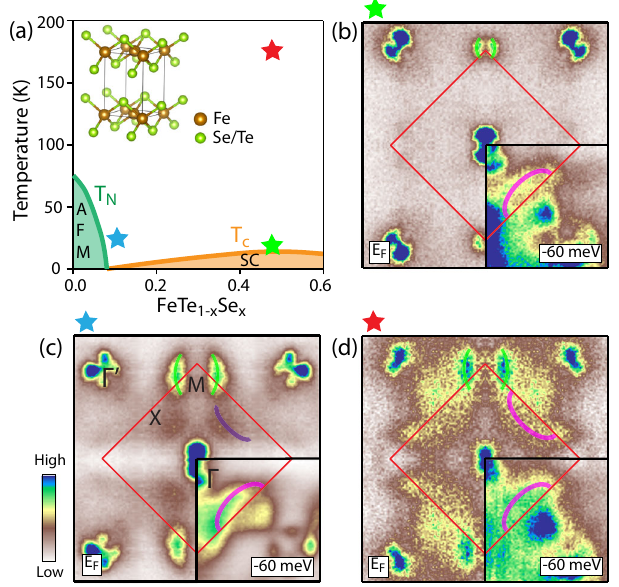
Fig. 1 Fermi surface evolution across the phase diagram of FeTe 1 − x Se x . a Phase diagram of FeTe 1 − x Se x showing where the Fermi surfaces are measured. b Fermi surface and constant energy contour measured at − 60 meV (lower right inset) for FTS44 taken at 18 K. c , d Same as ( b ) but taken on FTS11 at 24 K and FTS44 at 174 K, respectively. The red diamonds mark the 2-Fe Brillouin